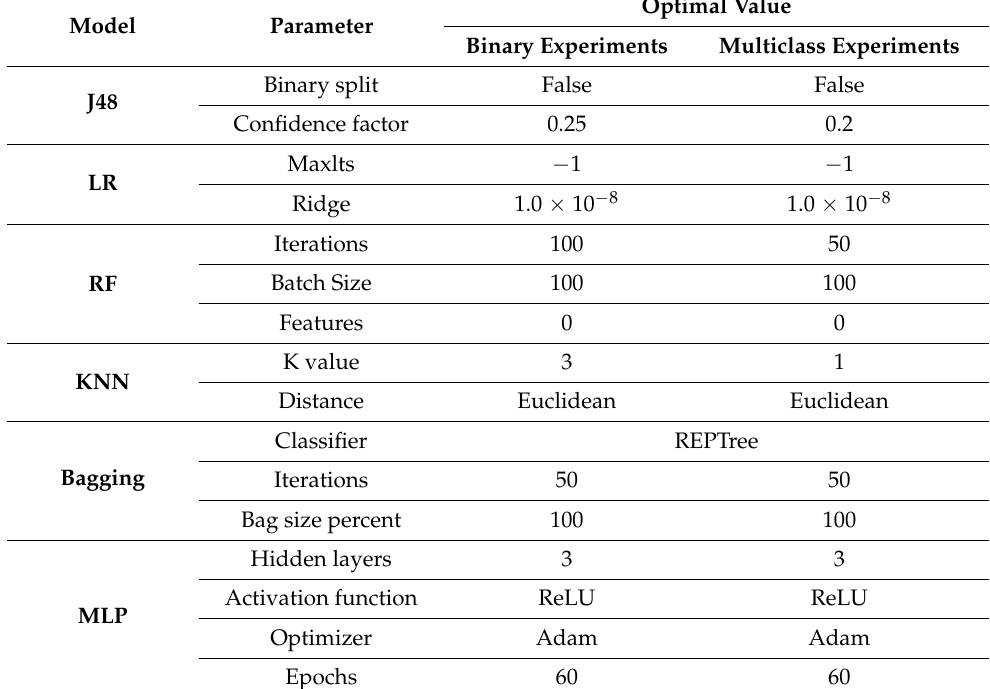
Table 5. Parameter optimization settings.